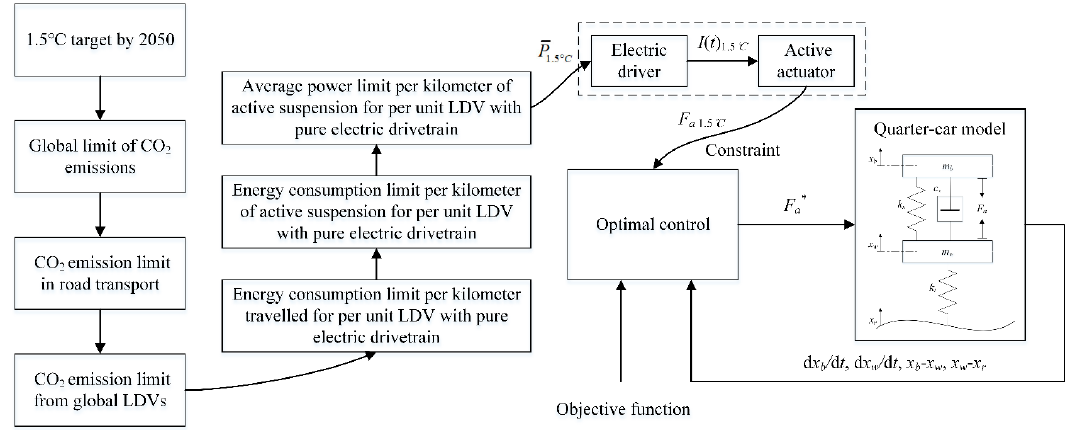
Figure 2. Full vehicle model of regenerative suspension. Framework of active suspension optimal control design for meeting the 1.5 °C target. LDV, light-duty vehicle.